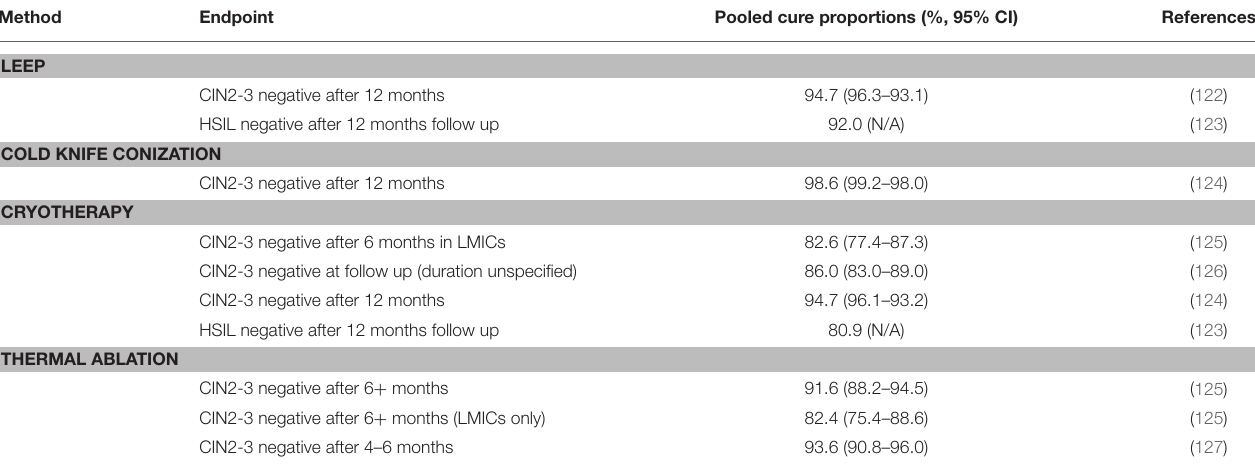
TABLE 5 | Summary of efficacy of LEEP, cold knife conization, cryotherapy, and thermal ablation.